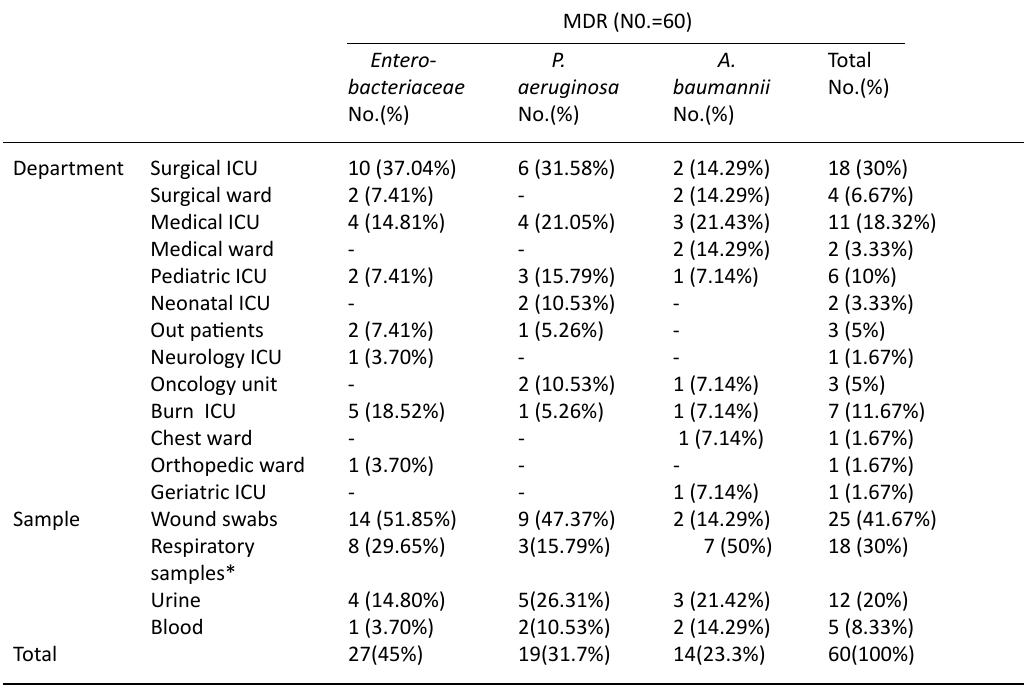
Table 1. The distribution of MDR Gram negative bacterial isolates in different wards and different